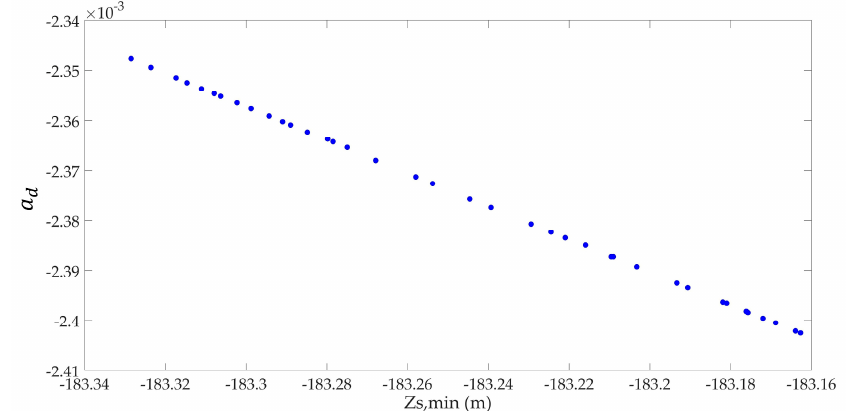
Figure 11. Pareto front for downsurge.